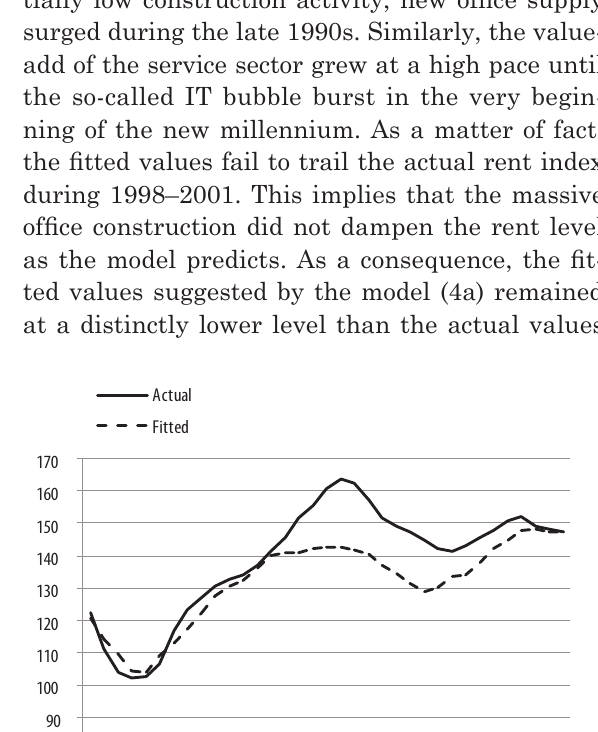
Fig. 8. CUSUM test graph for the model